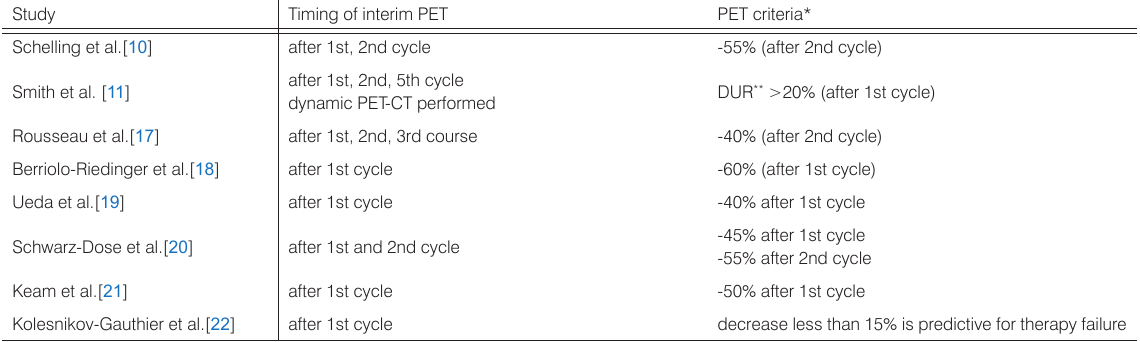
Table 2. Studies evaluating the metabolic response with FDG-PET-CT after the first cycle of PST. Study Timing of interim